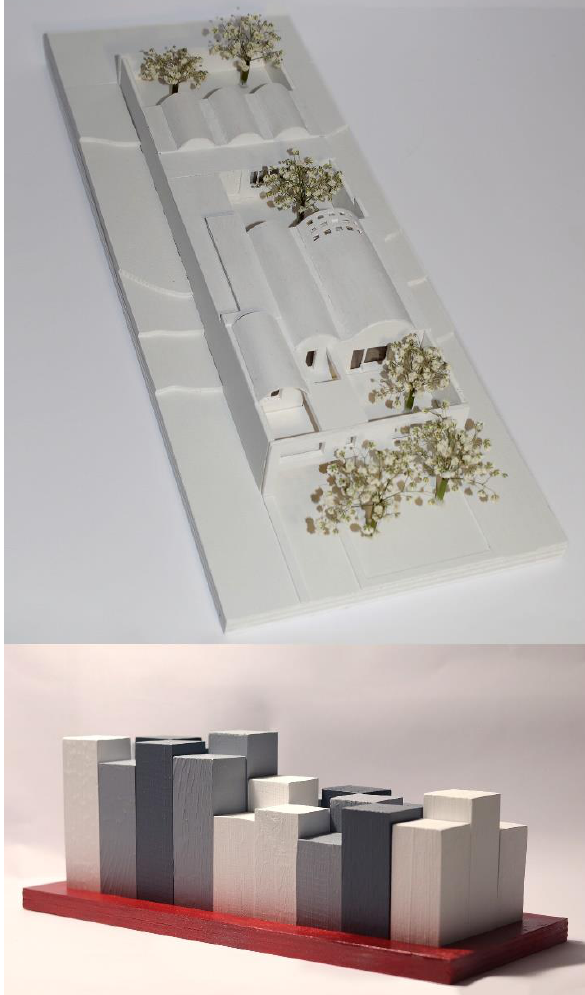
Figure 10. Eladio Dieste, Casa Eladio Dieste (1961) Montevideo. Realistic scale model (above) and its related conceptual